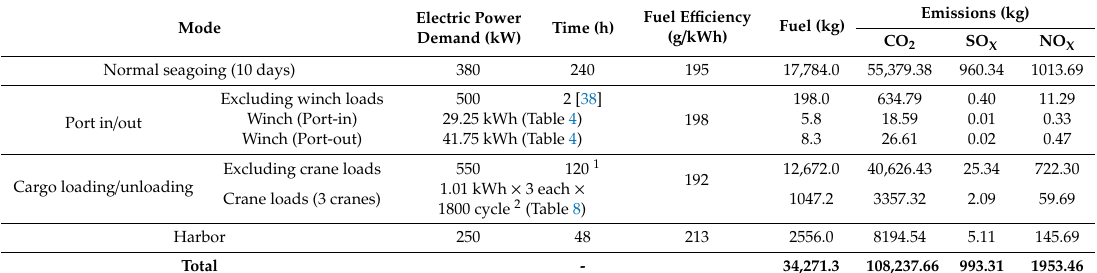
Table 13. Emissions from onboard gensets for each mode (conventional system).